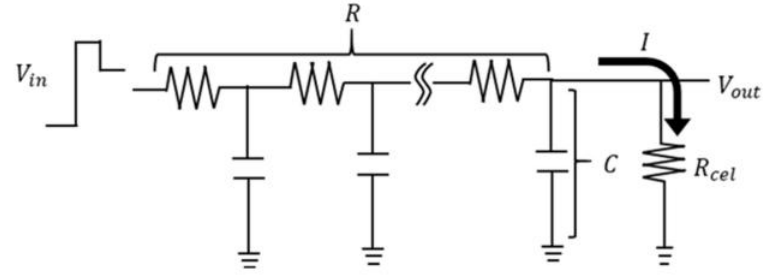
Figure 12. WL line model when cells flow at cell current.